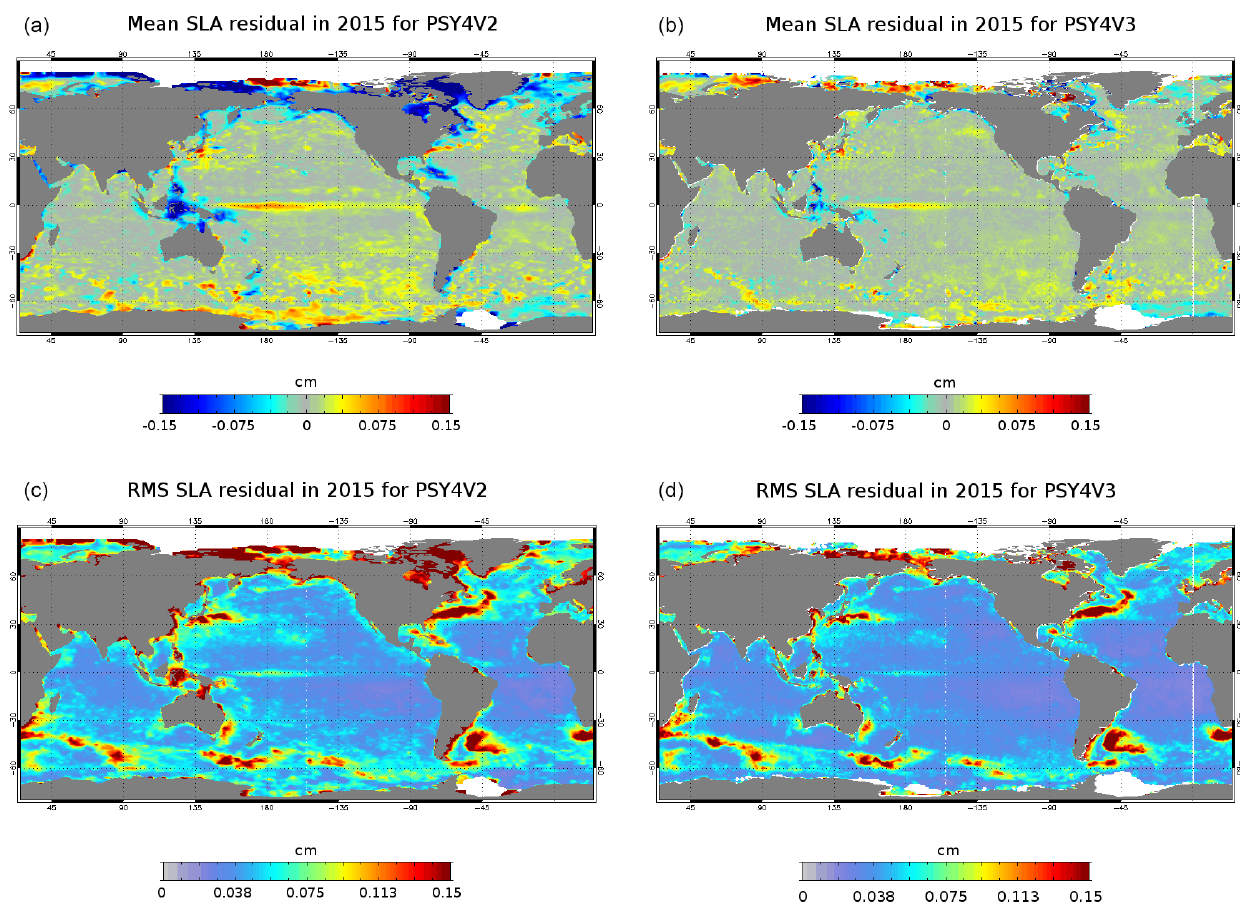
Figure 24. Mean residual errors (a, b) and RMS residual errors (c, d) of SLA in 2015 for the previous system PSY4V2 (a, c) and the new system PSY4V3 (b, d) . Unit is